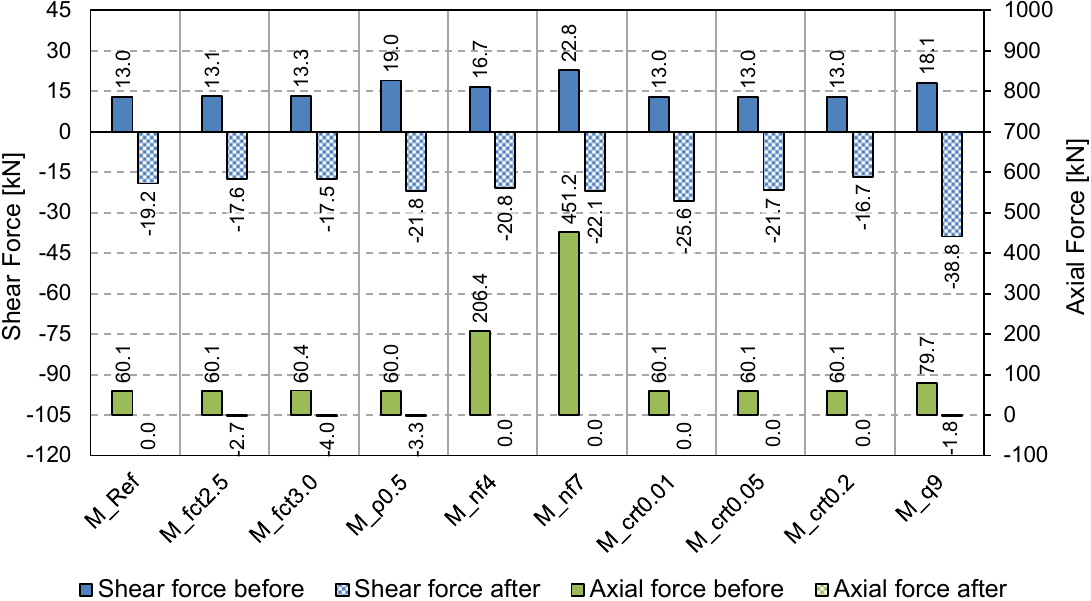
Figure 13. Shear and axial force of first floor column P3 before and after column removal for the di ff erent models. Positive axial force values indicate compression.